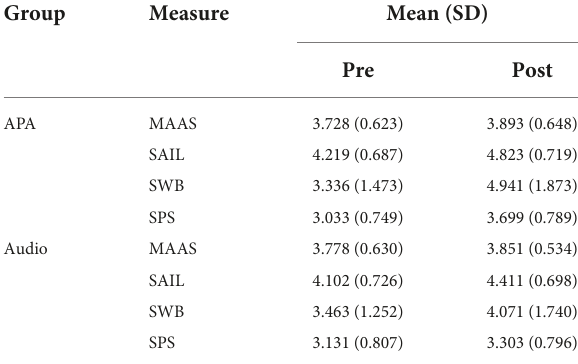
TABLE 3 Means and standard deviations for each measure of each group, pre- and post-assessment.